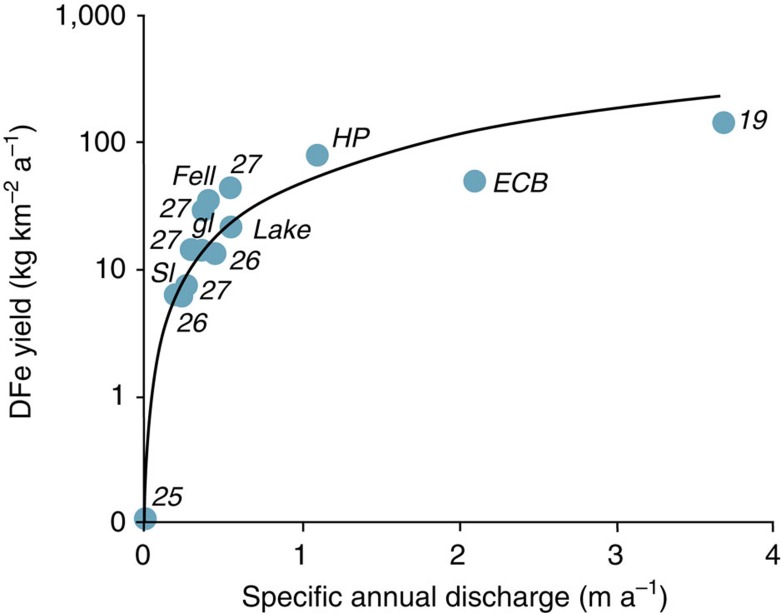
Annual runoff and DFe yields from Arctic and Antarctic catchments.Hurd Peninsula (HP), East Cumberland Bay (ECB) and Signy Island (SI) data are from Table 1. The separate glacial (‘gl'), fellfield (‘fell') and lake-influenced (‘lake') catchments on Signy Island are also shown, whilst numeric labels correspond to published studies in the reference list.